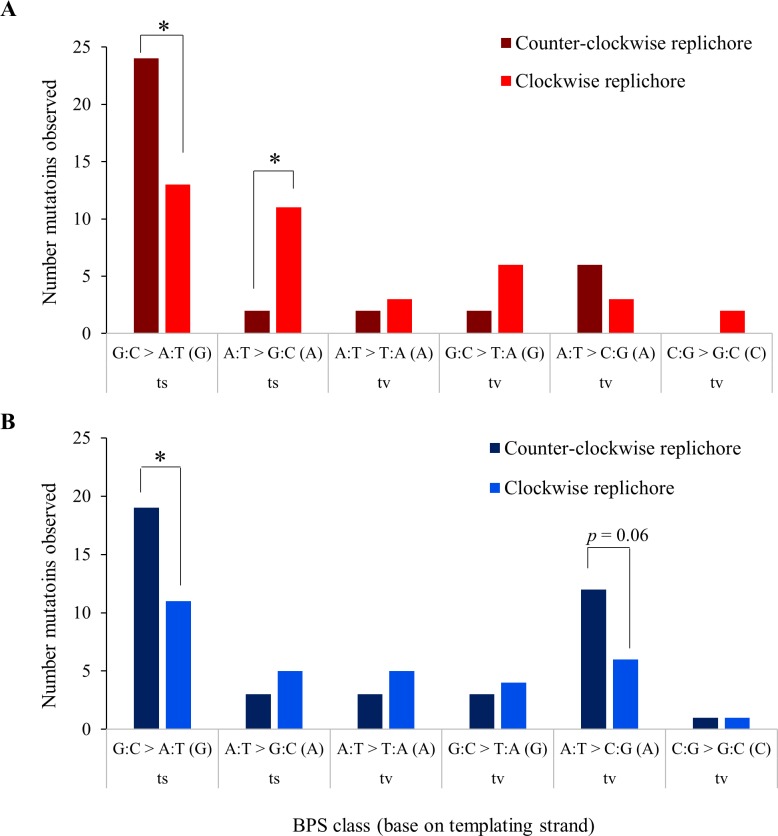
Frequencies of BPSs in the clockwise and counter-clockwise replichores of A) aerobic and B) anaerobic lineages. Expected values account for the uneven replichore sizes for REL4536 (clockwise replichore is 2.06 Mb, whereas the counterclockwise replichore is 2.54 Mb), and the assumption of equal mutation rates on the leading and lagging strand. * p < 0.05 by Pearson’s χ2-test.